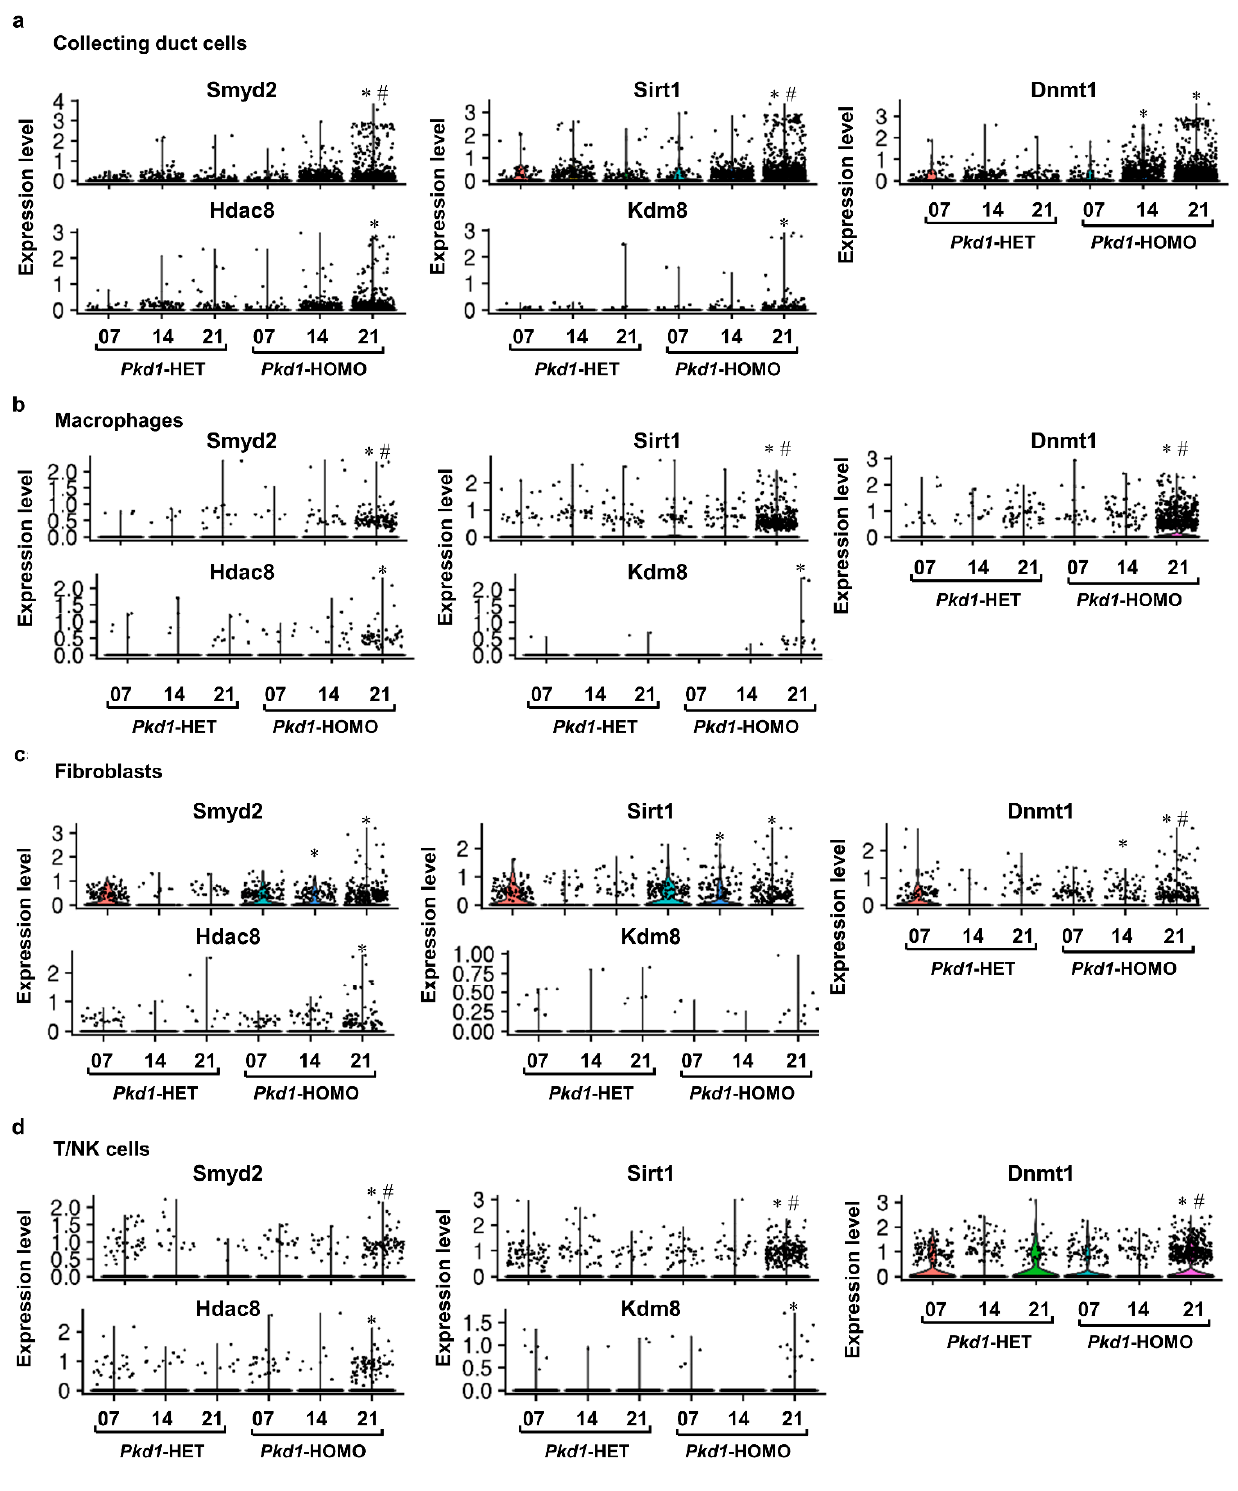
Figure 9. The expression of epigenetic factors was changed in collecting duct cells, macrophages, immune cells and fibroblasts. ( a – d ) Violin plot showing the upregulations of Smyd2, Sirt1, Dnmt1, Hdac8 and Kdm8 in collecting duct cells ( a ), macrophages ( b ), fibroblasts ( c ) and T/NK immune cells ( d ) across days 7, 14 and 21 in Pkd1 HET and HOMO mouse kidneys. * represents the comparison between Pkd1 HOMO kidneys and age-matched Pkd1 HET kidneys ( p < 0.05). # represents the comparison between Pkd1 HOMO 21 kidneys and Pkd1 HOMO 7 and 14 kidneys, respectively ( p < 0.05), as calculated by a one-way ANOVA test.